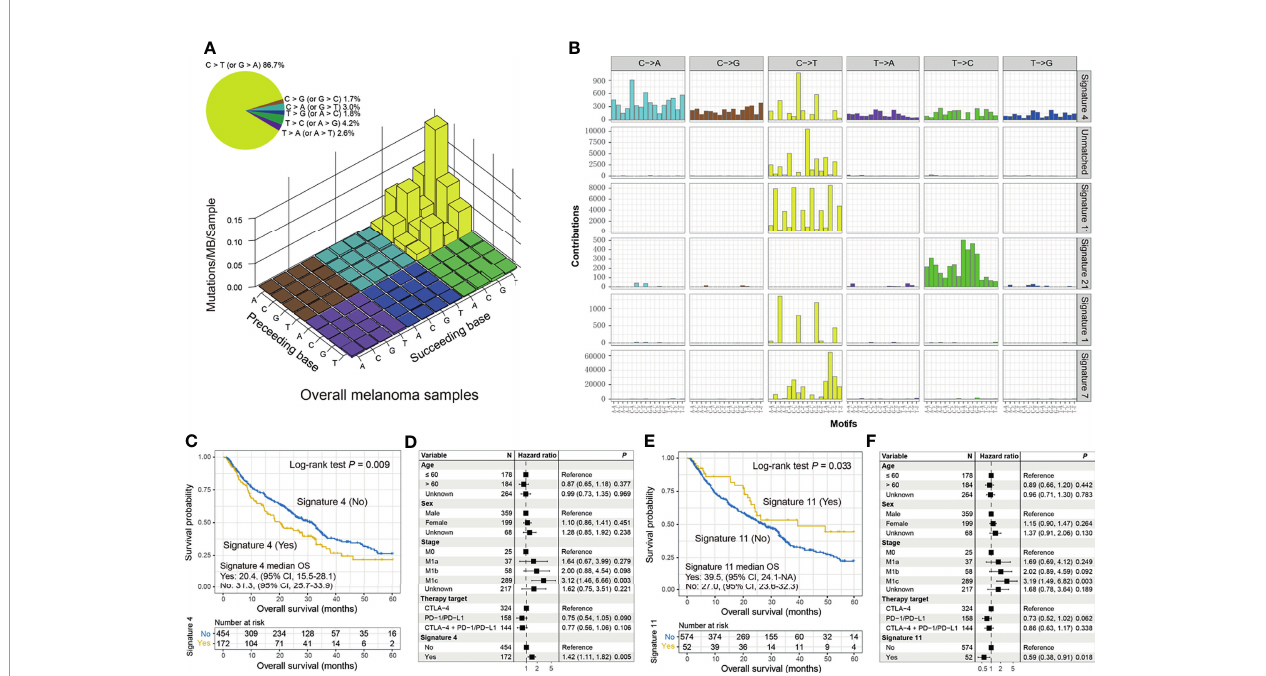
FIGURE 4 | Mutational signatures extracted from the integrated melanoma cohort and their association with immunotherapy prognosis. (A) Lego plot representation of mutation patterns in 631 melanoma cases. Single-nucleotide substitutions are divided into 6 categories with 16 surrounding fl anking bases. The inset pie chart displays the proportion of 6 mutational patterns. (B) The activities of corresponding extracted mutational signatures (i.e., signatures 1, 4, 7, 11, and 21, and unmatched signature). The trinucleotide base substitution types are shown on the x-axes, whereas the y-axes illustrate the contribution percentage of distinct mutation types in each mutational signature. The Kaplan – Meier overall survival (OS) analysis of (C) signature 4 and (E) signature 11. Multivariate Cox regression models of (D) signature 4 and (F) signature 11 with age, sex, stage, and therapy type taken into